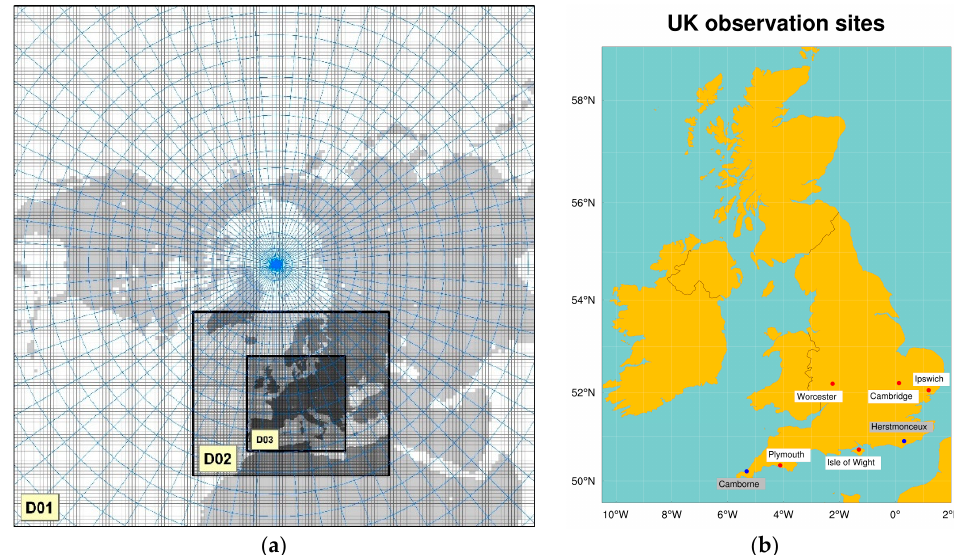
Figure 1. Left ( a ) showing the geographical setup of the three model domains in the WRF ‐ Chem extension with 108 km (D01), 36 km (D02) and 12 km (D03) resolution (model results provided from the inner domain 3). Right ( b ) showing the UK with the location of the 6 pollen monitoring sites (red dot and white background text) and the 2 sites with radio ‐ soundings (blue dots, grey background text) used in the study.